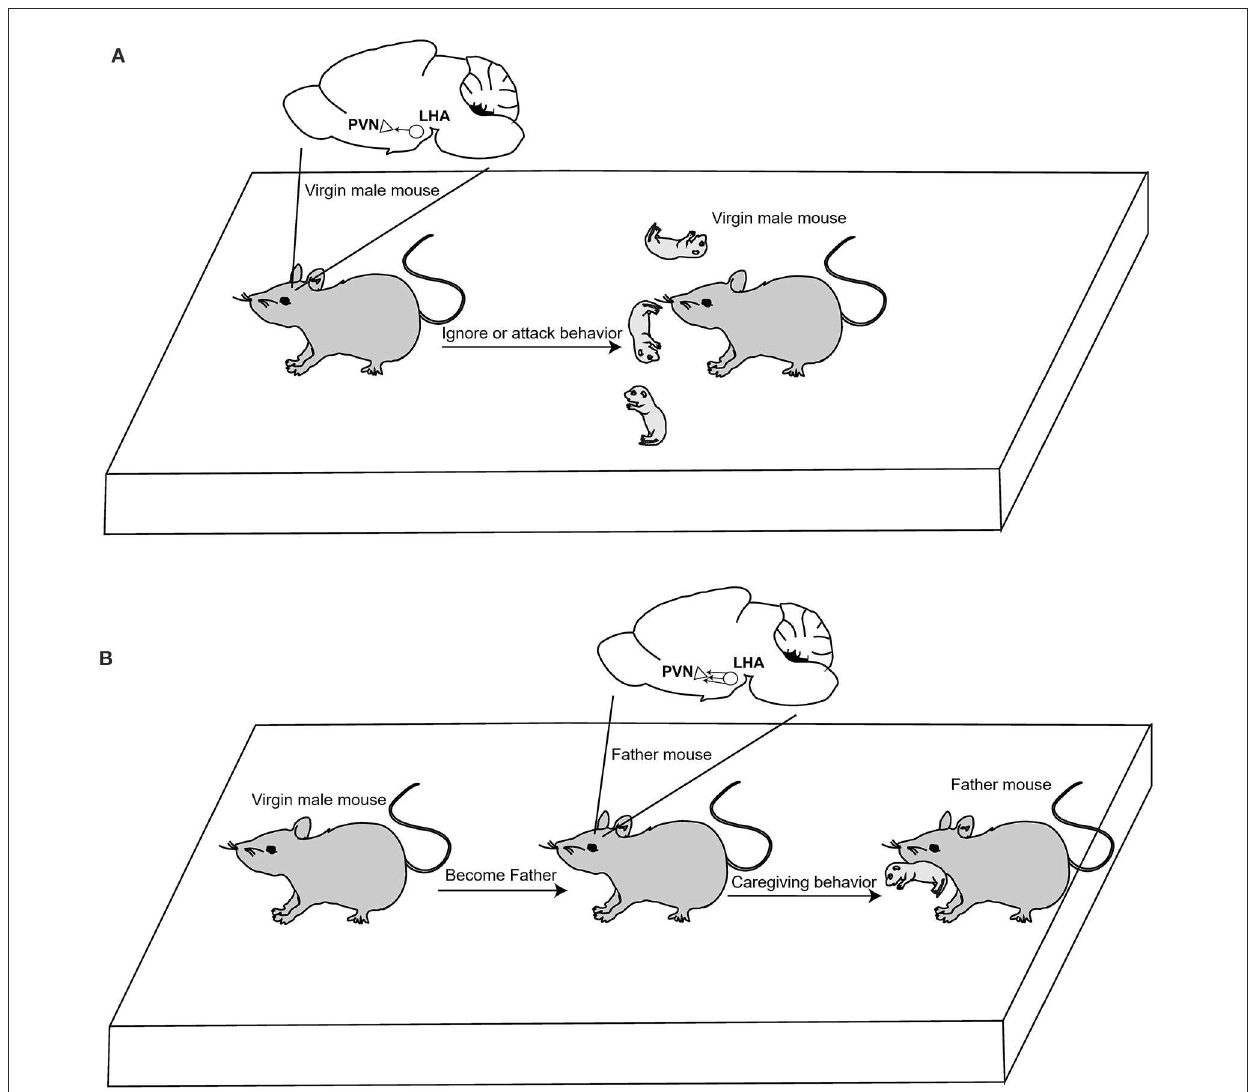
FIGURE1 OT neuron activation facilitates caregiving behavior in virgin male mice. (A) In normal conditions, virgin male mice attack and ignore pups; they do not display parental caregiving behavior. (B) Neural connections originating from the LHA to the PVN OT neurons were drastically strengthened when male mouse became father. Activation of OT neurons in the PVN can induce caregiving